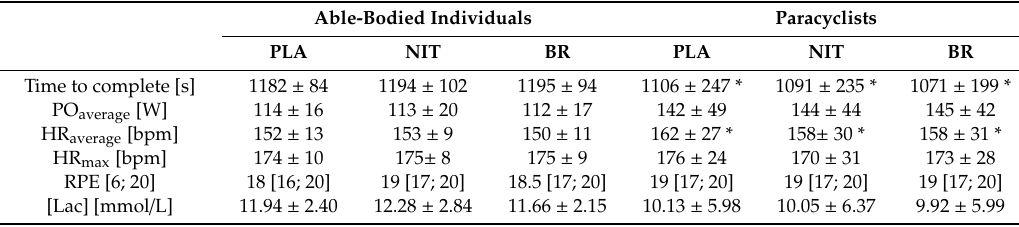
Table 5. Data from the 10 km time trail (TT) performance in both groups of participants. Able-Bodied